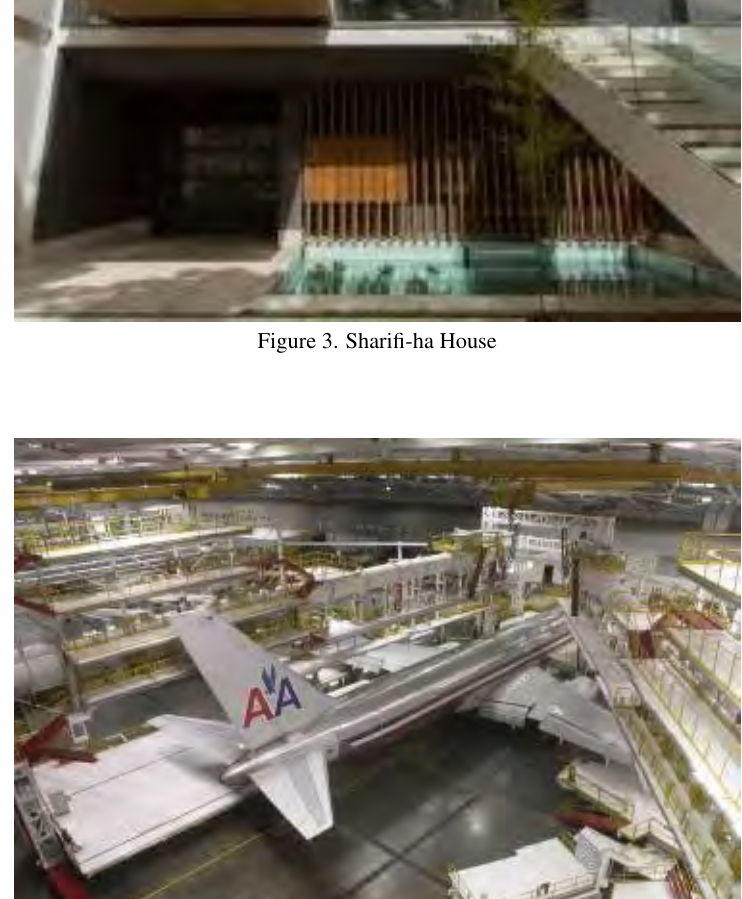
Figure 4. American Airlines by